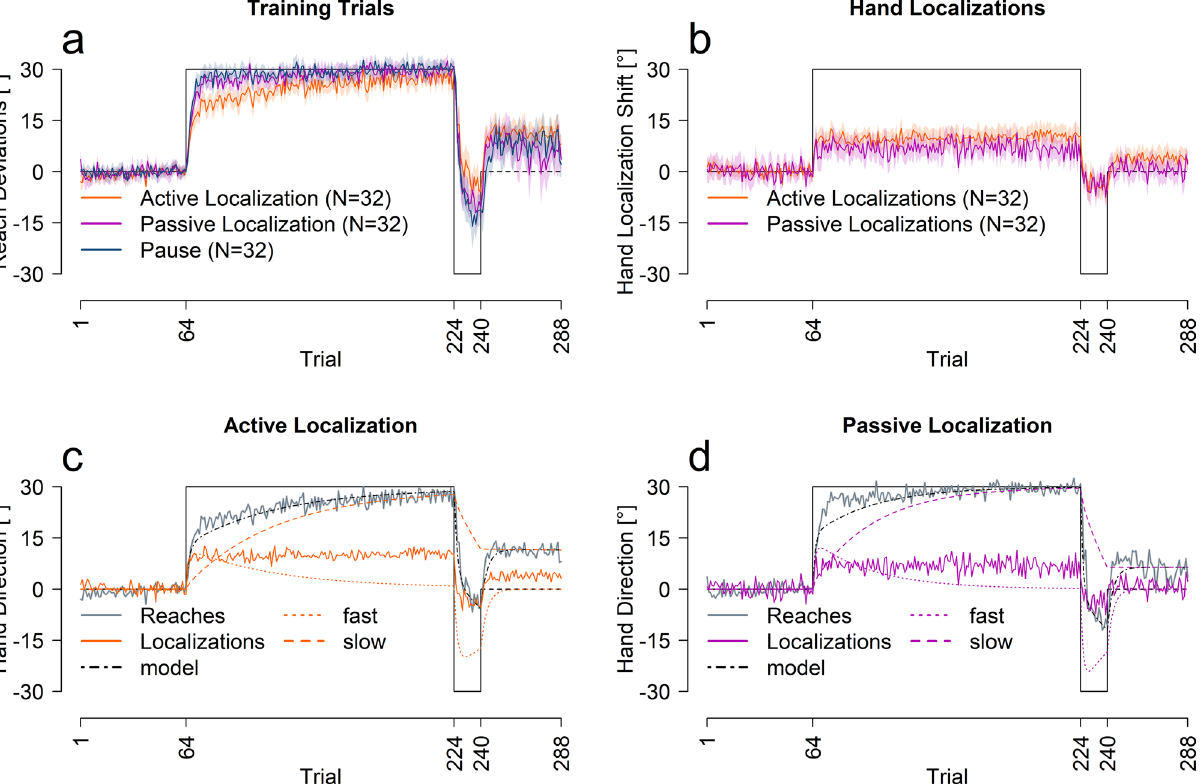
Figure 2. Performance across measures for passive, active and pause groups. ( a ) Reach training performance averaged across all participants for each corresponding group. ( b ) Hand localization performance for the two groups. ( c,d ) Model predictions for the active and passive localization groups. All solid lines are an average of all participants in that group, shaded regions are 95% confidence